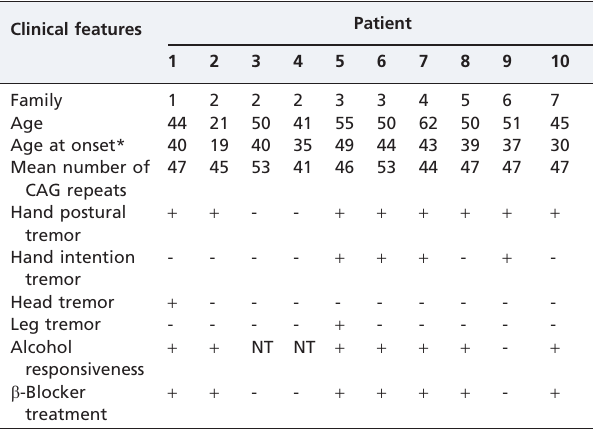
Table 1 – Clinical features of Kennedy’s disease (tremor) and molecular genetic testing in 10 patients (from 7